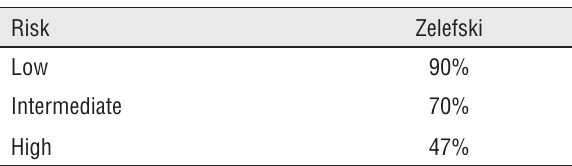
Table 4b - 5 year biochemical freedom from failure rate published by Zelefski after external beam radiation therapy in different risk groups. The results are comparable with the results in table 4a.